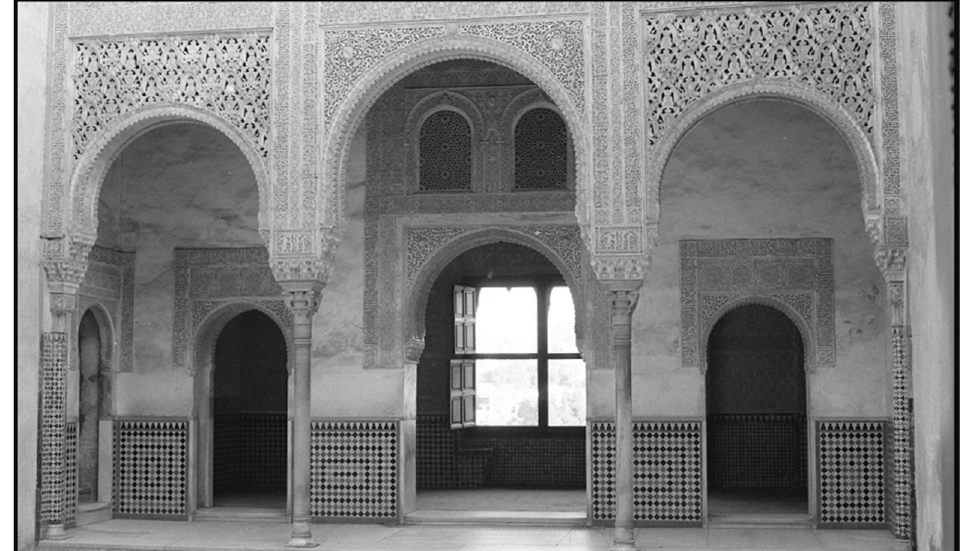
Figure 33. Cuarto Dorado portico showing the complete replacement of alicatado work on both the dadoes and the engaged columns. Photograph by Abelardo Alonso Gallardo, 19 November